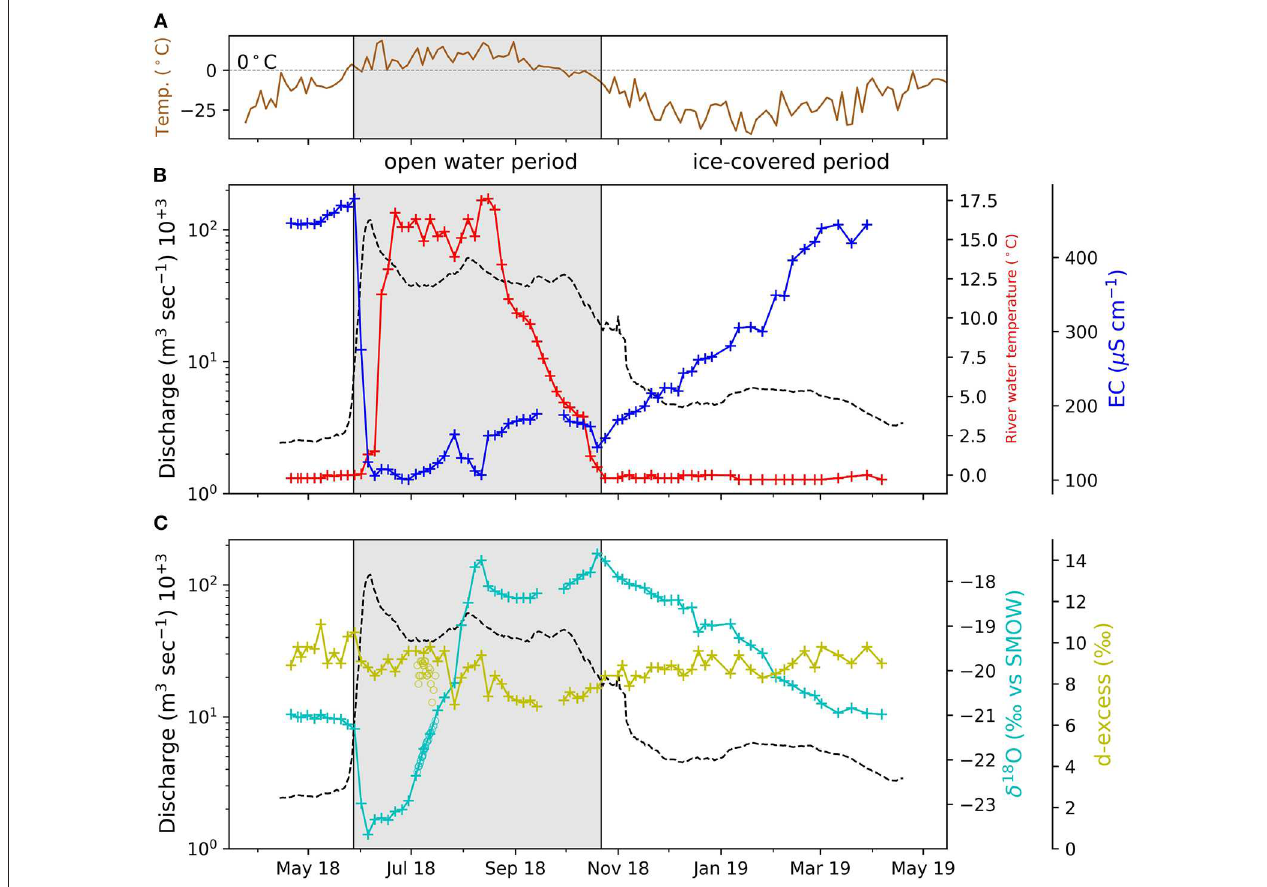
FIGURE 3 | Air temperature, measured Figure 2 in Tiksi (A) , discharge (black dashed line) (B,C) , river water temperature and EC (B) and δ 18 O and d-excess (C) . The gray area indicates the period where the Lena River channels around Samoylov Island were not ice covered (dates are based on optical satellite imagery). The EC values are those from measurements made in the laboratory following sampling. Circles in respective colors in (C) show high frequency measurements from July 2018.